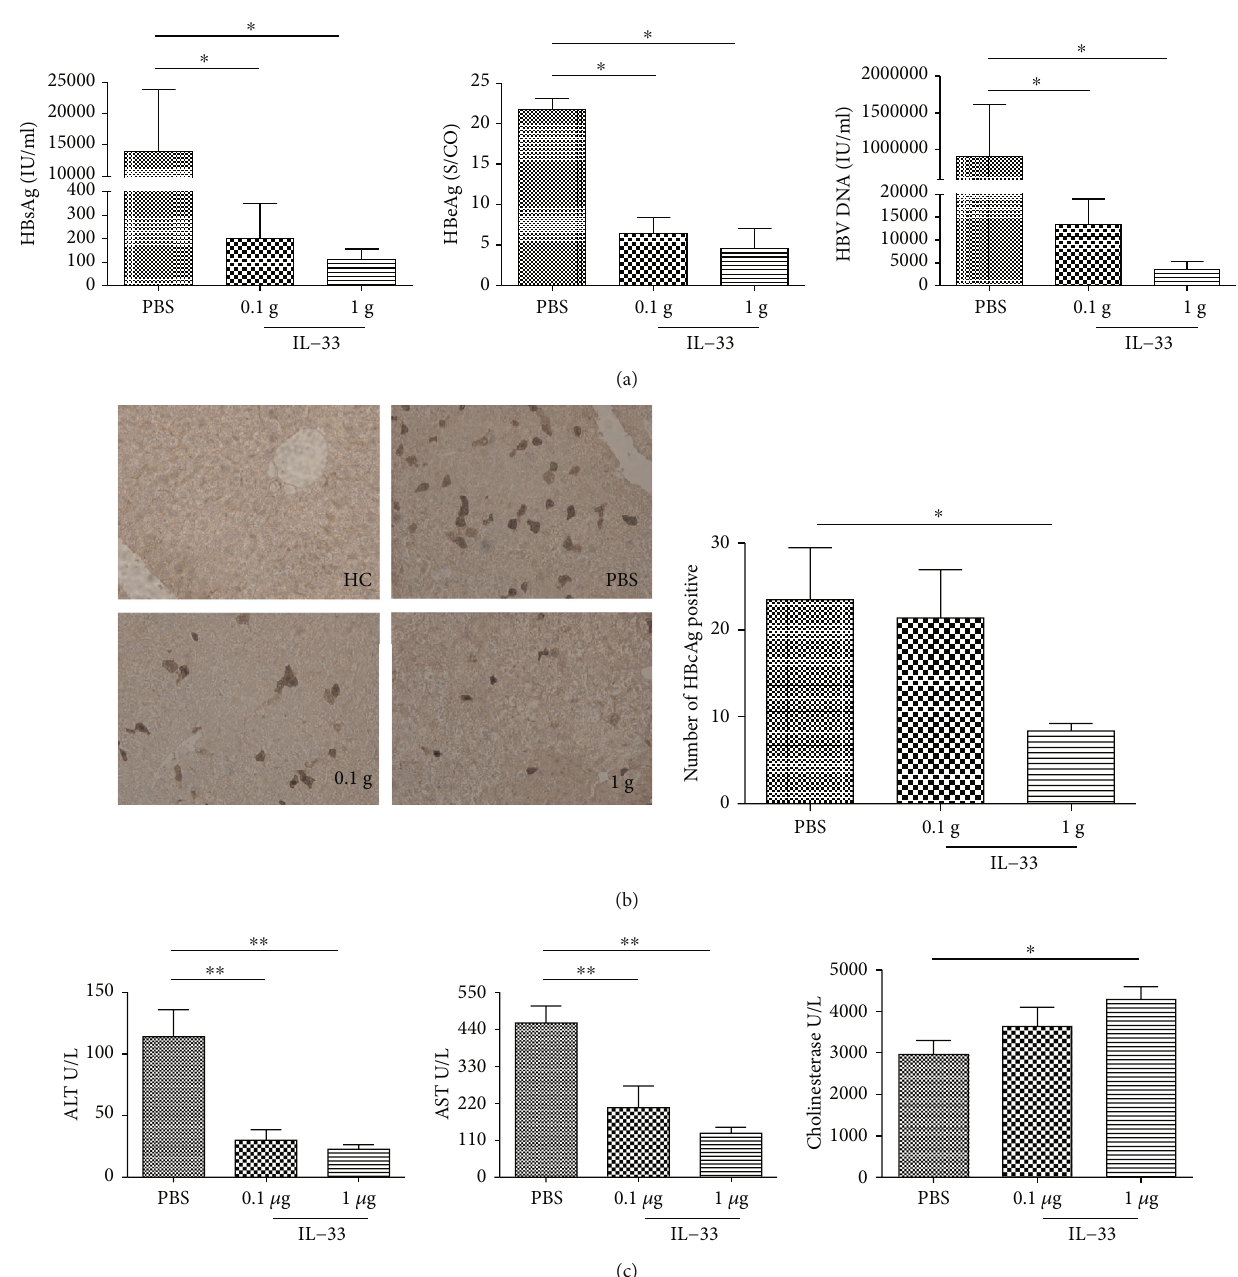
Figure 1: IL-33 treatment inhibits HBV in the hydrodynamic HBV mouse model in a dose-dependent manner. C57BL/6 mice were injected intraperitoneally with IL-33 (0.1 and 1 μ g/mouse) and PBS (1 ml/mouse) daily for 1 week, respectively. The concentrations of HBsAg, HBeAg, and HBV DNA in the serum of HBV mice (a). Images of HBcAg staining detected by histological study in liver sections were from HBV mice (b). The levels of ALT and AST and cholinesterase in the serum HBV mice (c). The statistical signi fi cance of the data was determined using the Mann – Whitney test; P value is shown in each